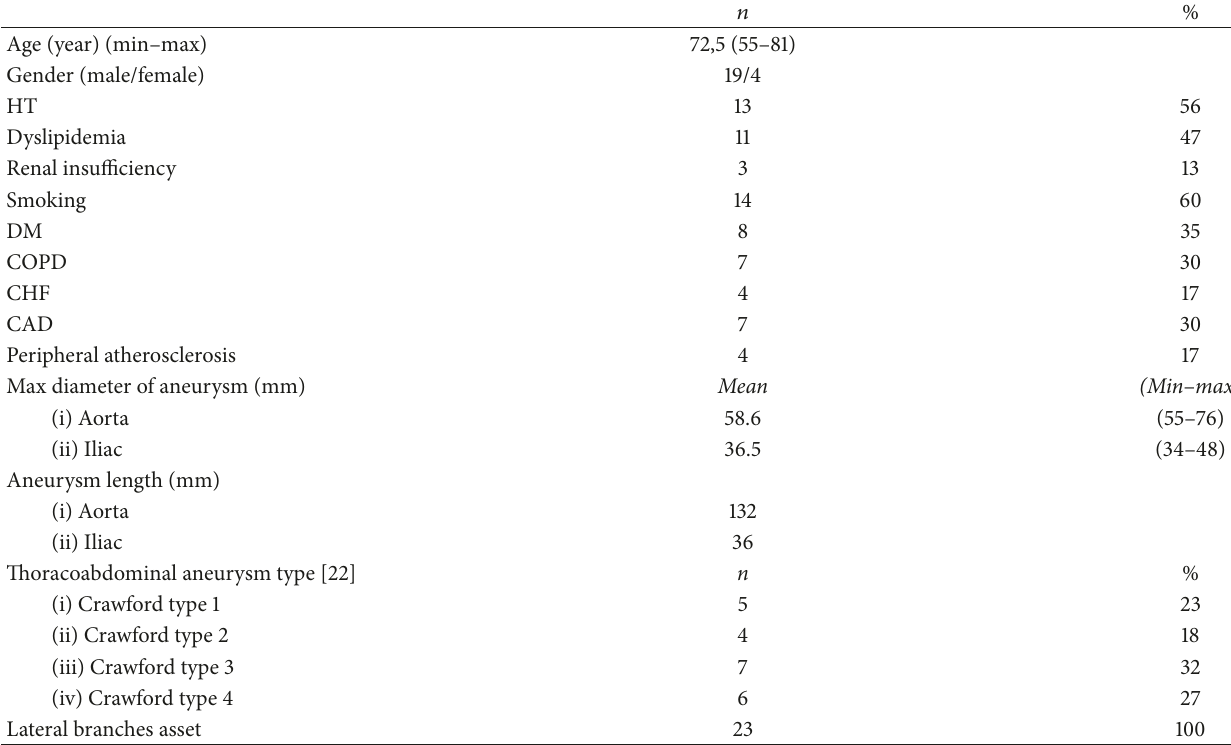
Table 1: Demographic characteristics of the patients and lesion